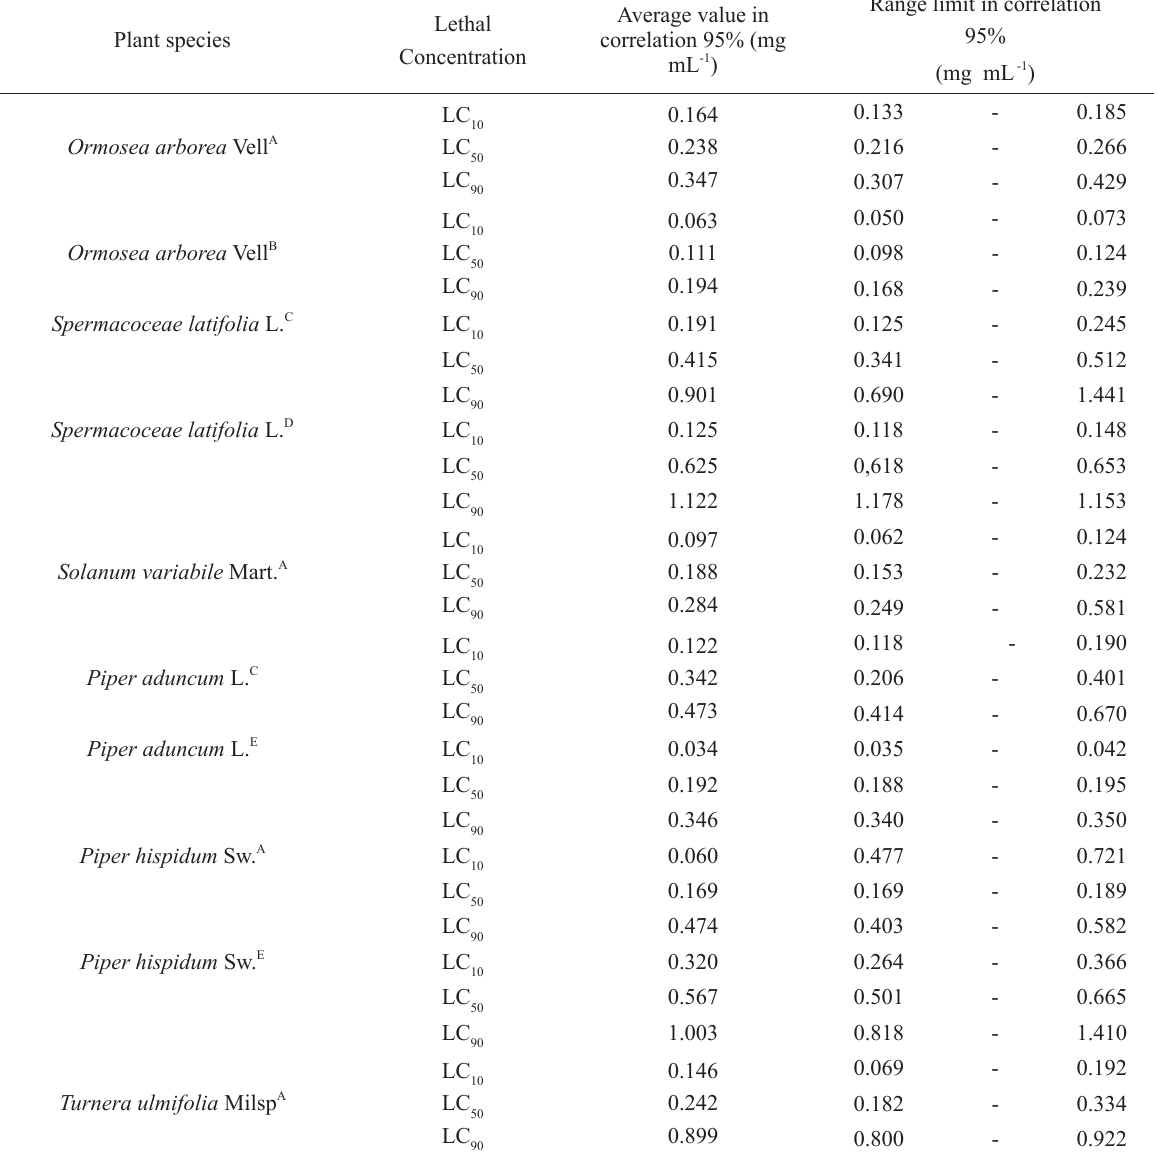
A= Ethanolic extract of leaves. B= Ethanolic extract of seeds. C= Hexane extract of leaves. D= Methanolic extract of leaves. E= Chloroform extract of